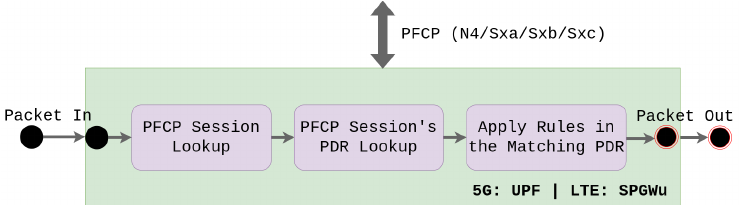
Figure 5. Flow of packet processing in UP function defined by UPF and SPGWu, components of NGC and EPC